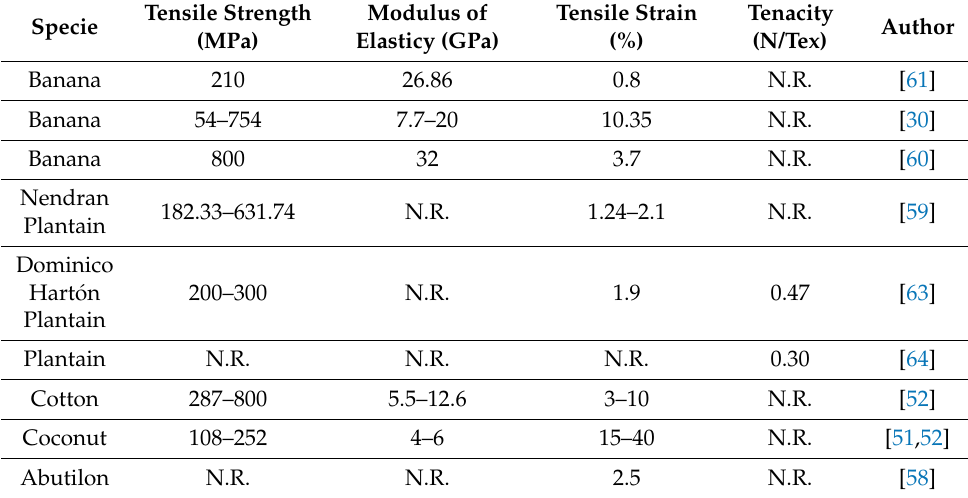
Table 4. Tensile properties of different lignocellulosic